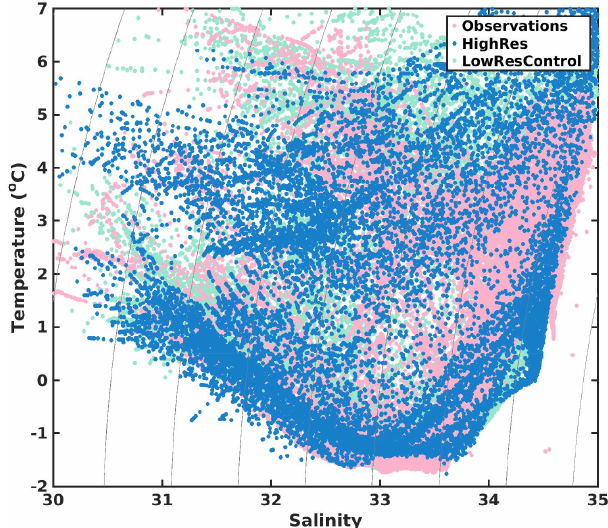
Figure 7. Temperature and salinity plot for the region around the Davis Strait sill ( ∼ 30km). Observations contain data collected by the Davis Strait program’s fall mooring cruises. Observations are taken in the fall months, late August to October, for the years 2004 to 2010. Model fields are plotted the same for HighRes and LowRes Control (mid-September and mid-October fields, within ∼ 30km of the Davis Strait sill, from 2004 to 2010). Model fields are subsam- pled to a 0 . 5 ◦ grid to reduce the number of points plotted. Points with a salinity of less than 30 or more than 35 or that are warmer than 7 ◦ C are excluded. Thin curved black lines are density in given in values of kilograms per cubic